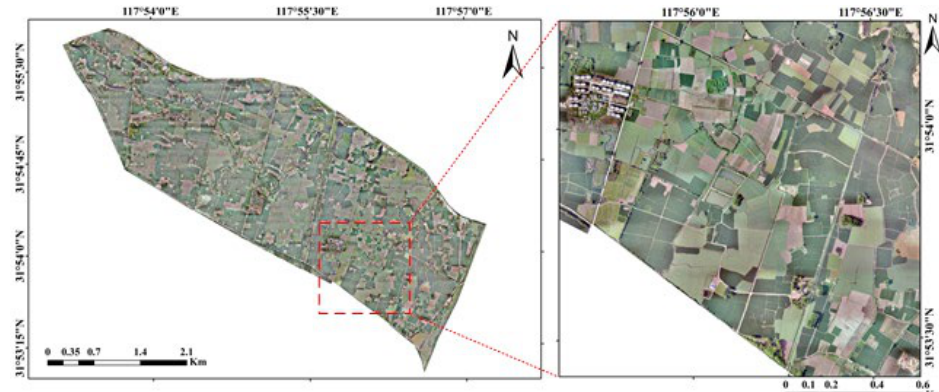
Figure 3. UAV survey area. (These data were not included in the experiment and were only used for fine confirmation of feature types and to enhance the reliability of sample establishment.).